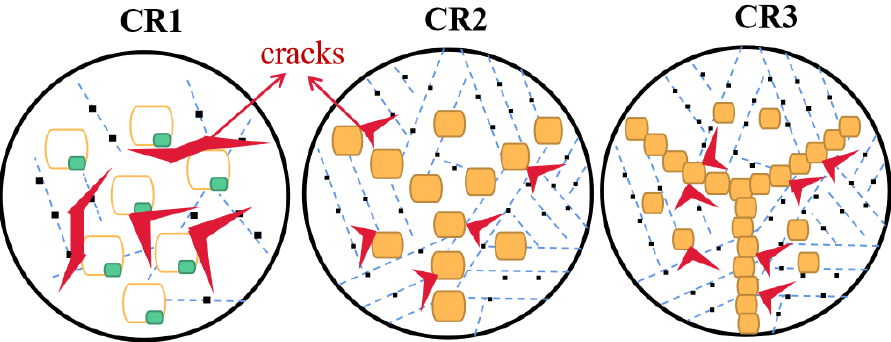
Figure 8. Illustration of impact fracture mechanism of ICR CGHAZ with different cooling rates.